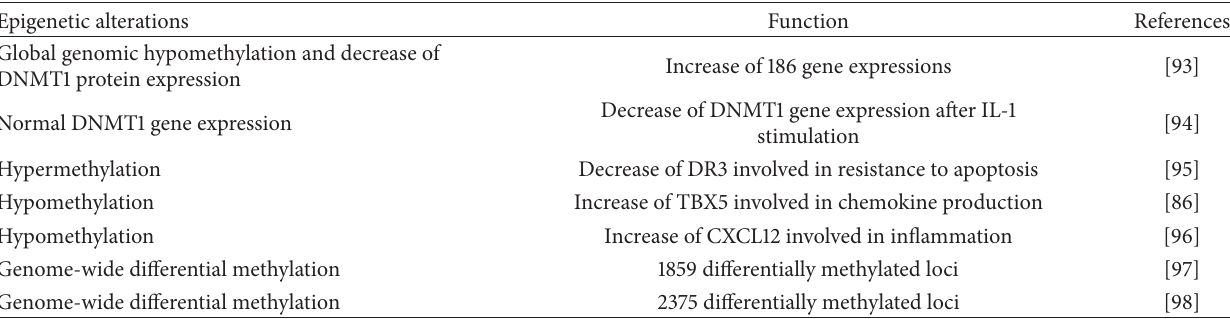
Table 2: Abnormality of DNA methylation in